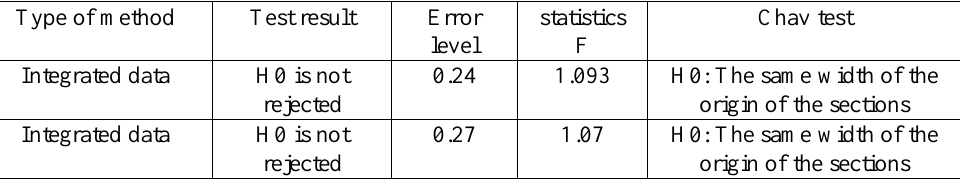
Table 4. Results of F-Limer or Chow test (width matching of cross-sectional